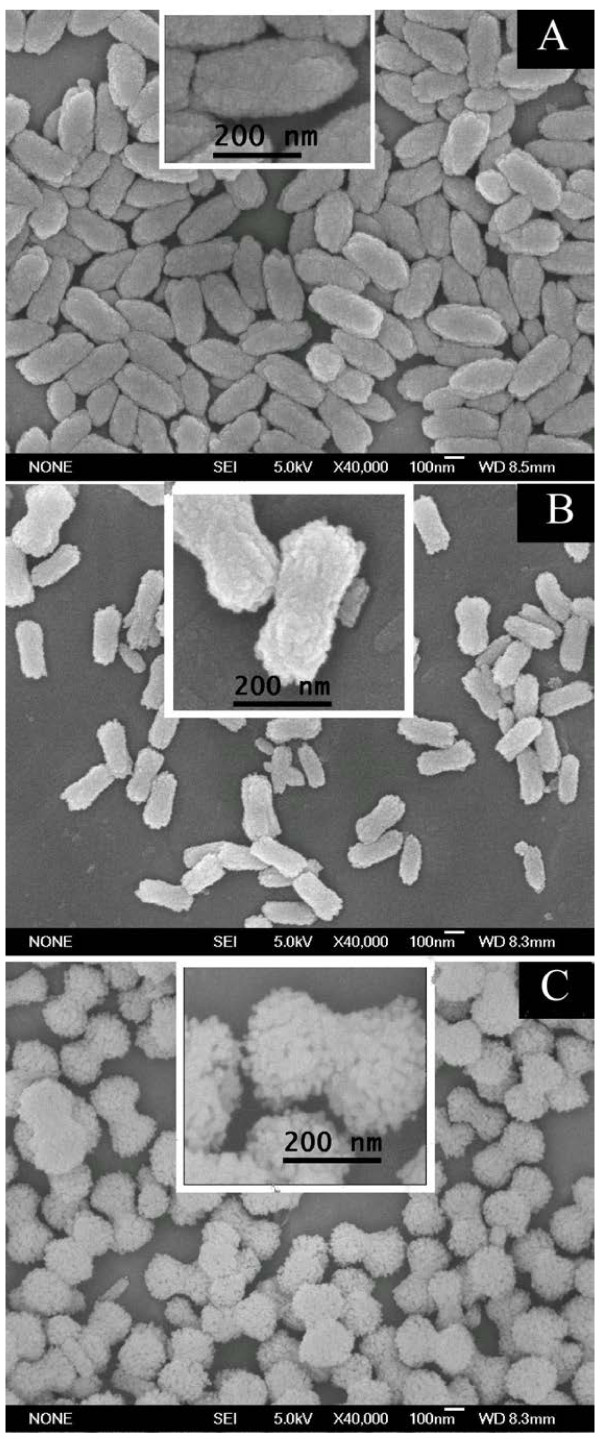
SEM images of SrCO3products synthesized in pure methanol at (A) 70°C, (B) 60°C, (C) 50°C. Insets are the magnification.